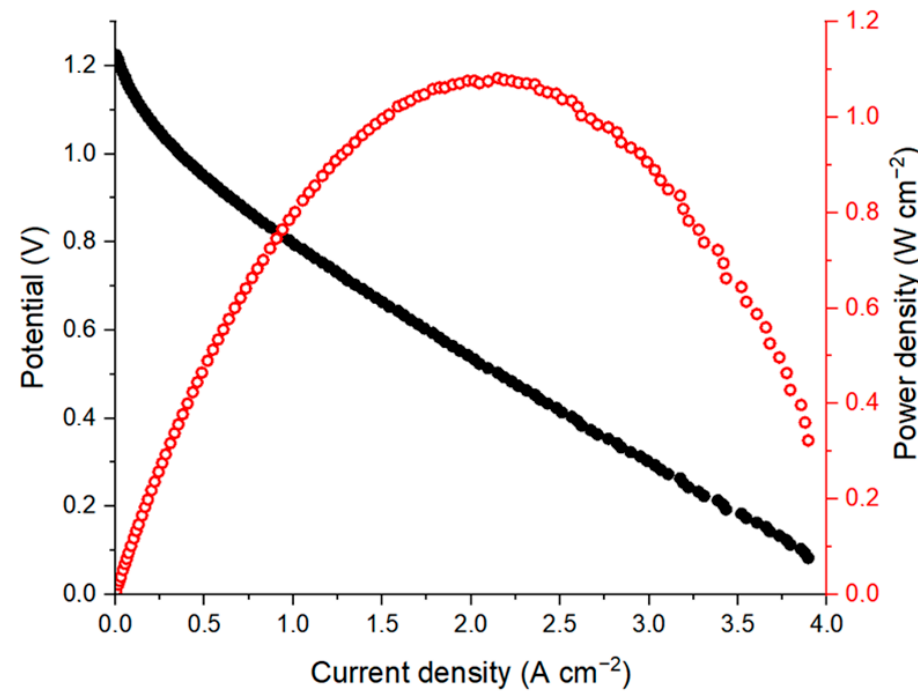
Figure 3. Polarization curve (black dots) and corresponding power density (red dots) for an AQBRFB. SOC: 100%, membrane: Nafion-211, temperature: 50 °C, flow: through flow field, flow rate: 100 mL min − 1 . Posolyte composition: 1 M LiBrO 3 in 6 M H 2 SO 4 , negolyte composition: 0.8 M AQDSH 2 in 1 M H 2 SO 4 .